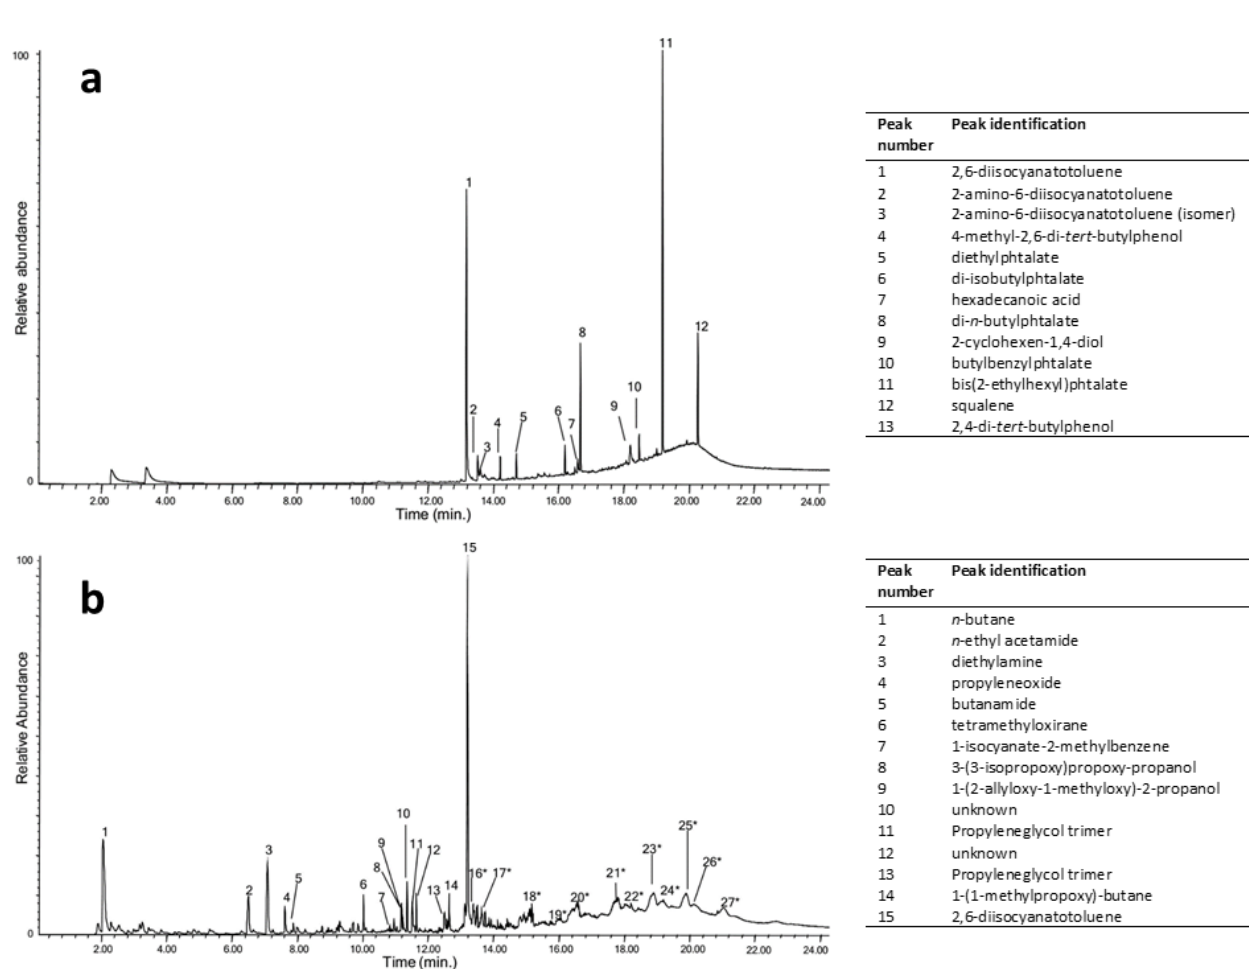
Figure 2. Pyrolysis–GC/MS (Py-GC/MS) chromatograms after first-shot pyrolysis at 306 °C ( a ) and after second-shot pyrolysis at 600 °C ( b ) of a bulk poly(ether urethane) from “Contenitoreumano”, and identification of corresponding chromatographic peaks. Peaks from 16 to 27 correspond to oligomers. Image reprinted with permission from [44].